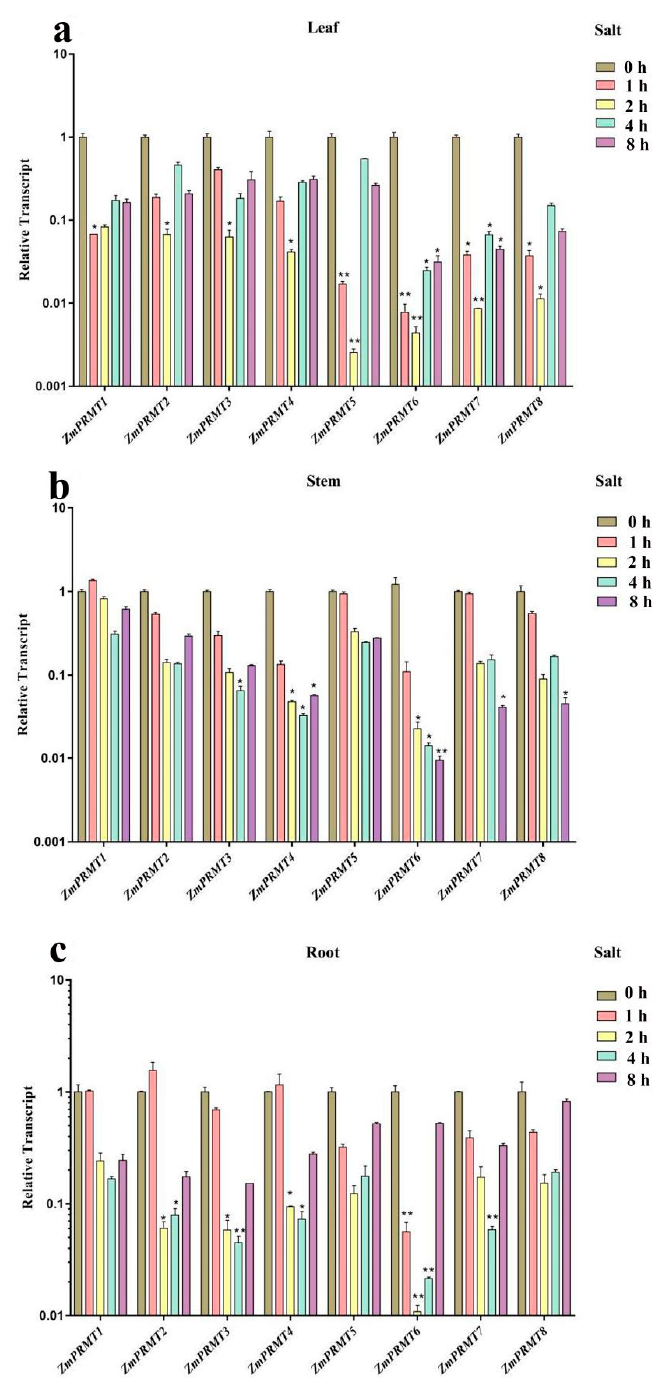
Figure 7. Expression profiling of the 8 ZmPRMT genes exposed to salt stress treatment in maize tissues (roots, stems and leaves). ( a ) The expression profiling of the 8 ZmPRMT genes exposed to salt stress treatment in maize leaves. ( b ) The expression profiling of the 8 ZmPRMT genes exposed to salt stress treatment in maize stems. ( c ) The expression profiling of the 8 ZmPRMT genes exposed to salt stress treatment in maize roots. The qRT-PCR data was standardized with maize ZmActin1 gene. The control condition was represented as CK (0 h), and the heat stress conditions were represented as Salt (1 h, 2 h, 4 h and 8 h). X-axes represent the genes under different treatments, while y-axes represent the scale of the relative expression level of genes. Error bar is generated by three biological repetitions. The significance level is indicated by the asterisk at the top of the error bar. p < 0.05 is significantly different *; p < 0.01 is significantly different